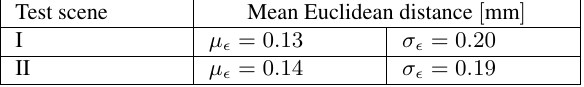
Table 1: Mean Euclidean distance error µ (cid:15) and standard deviation σ (cid:15) for the method of section